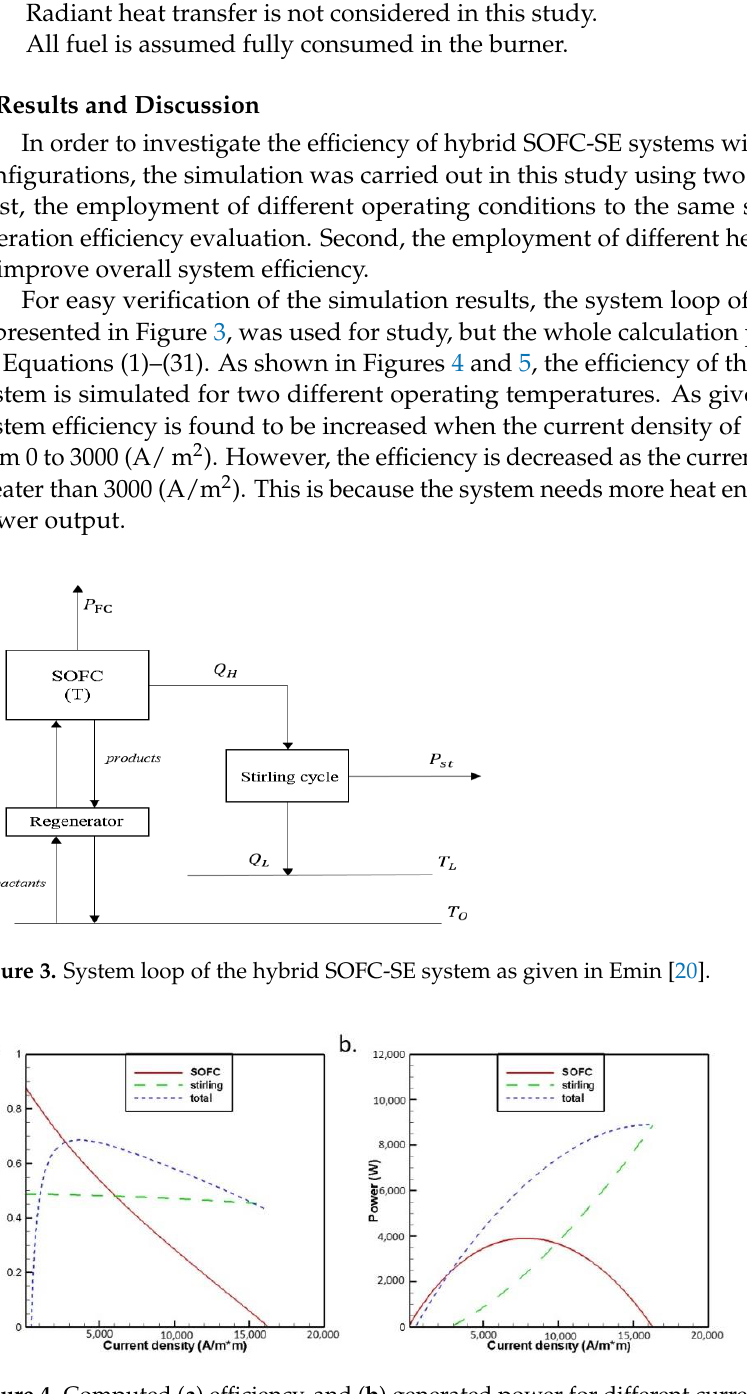
Figure 5. Computed ( a ) efficiency and ( b ) generated power for different current densities at 1173 K for the hybrid SOFC-SE system without heat components (Emin [20]). As shown in Figures 4 and 5, we observed that the maximum system efficiency of the hybrid SOFC-SE system is increased up to 68.52% when operated at 873 K, and 62.32%,